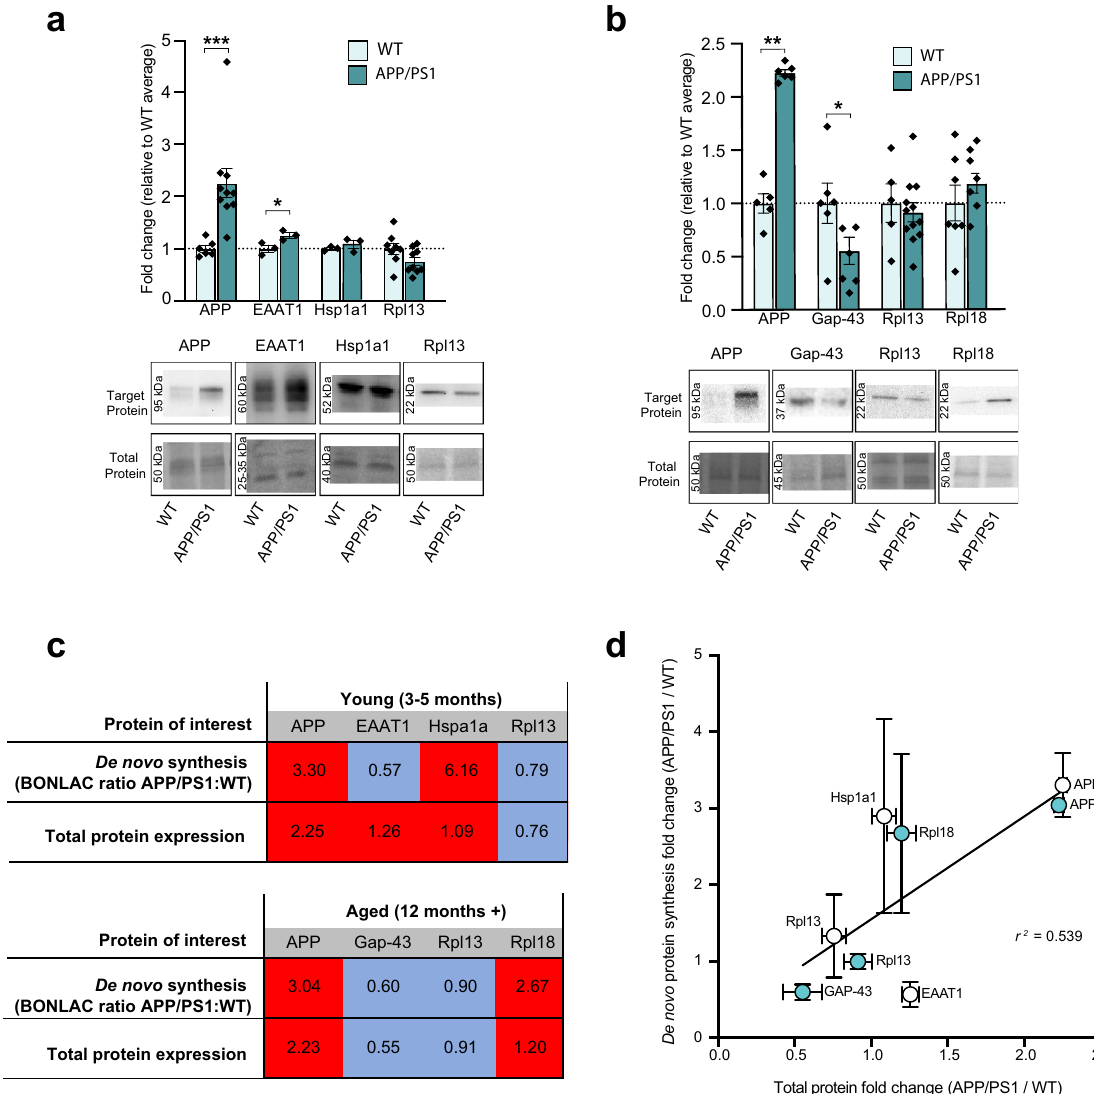
Fig. 4 Candidate proteins identi fi ed with BONLAC screen of de novo proteome exhibit altered expression levels in APP/PS1 mice. a Western blot quantitation of candidate proteins selected from BONLAC screen in 3 – 5-month-old wild-type (WT; light bars) and APP/PS1 (dark bars) mice, normalized in- lane to total protein (as assessed by MemCode or Ponceau stain [note only a portion of the entire analyzed lane is presented in the fi gure]) and expressed relative to age-matched WT (Number of biologically independent animals samples: APP 3 – 5 month n = 8, 12 + month n = 6; EAAT1 n = 3; Gap- 43 n = 6; Hsp1a1 n = 3; Rpl13 3 – 5 month n = 9, 12 + month n = 12; Rpl18: n = 7); representative western blots show selected protein levels in WT and APP/ PS1 mouse hippocampal lysates. b Representative western blot and quantitation of candidate proteins selected from BONLAC screen in 12 + -month-old WT and APP/PS1 mice. c Comparison table showing average fold change in de novo synthesis of candidate proteins in young and aged APP/PS1 vs WT littermates as identi fi ed by BONLAC (young n = 5 biologically independent samples; aged n = 7 biologically independent samples) compared to change in total expression quanti fi ed by western blot. Statistical signi fi cance calculated between APP/PS1 and WT samples using unpaired two-tailed t -tests; young APP: t = 3.378, 95% con fi dence interval = 0.4571 – 2.047, effect size = 1.252 ± 0.3707, df = 14, p = 0.0045; young EAAT1: t = 2.945, 95% con fi dence interval = 0.0146 – 0.4966, effect size = 0.2556 ± 0.0868, df = 4, p = 0.0422; aged APP: t = 13.95, 95% con fi dence interval = 1.027 – 1.424, effect size = 1.226 ± 0.08782, df = 9, p < 0.0001; aged GAP-43: t = 2.266, 95% con fi dence interval = − 0.9047 to − 0.01774, effect size = − 0.4612 ± 0.2035, df = 12, p = 0.0427. d Linear regression showing correlation between average de novo synthesized protein fold change (as determined by BONLAC) vs. average total protein fold change (as determined via western blot) of candidate proteins in the APP/PS1 vs. WT hippocampus at 3 – 5 months (white circles) and 12 + months of age (teal circles; r 2 value = 0.690, vertical error bars: BONLAC; horizontal error bars: western blot; p = 0.0207). Graphs in a , b and d show mean ±